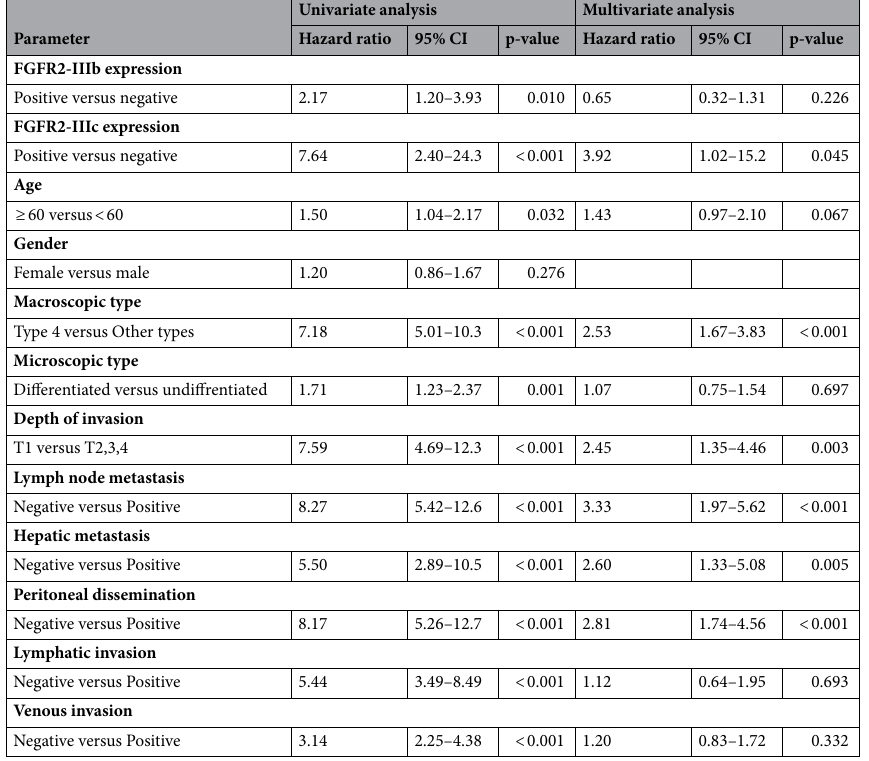
Table 3. Univariate and multivariate analysis with respect to overall